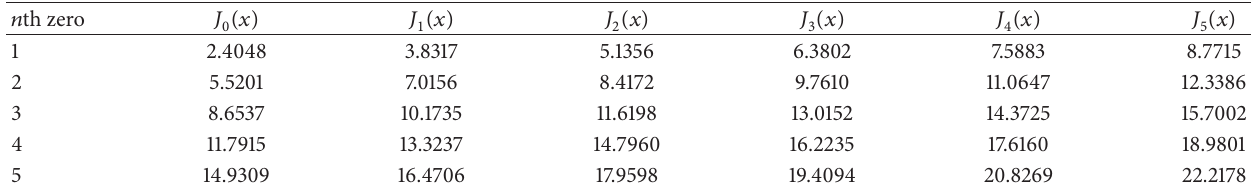
Table 1: Zeros of the Bessel functions 𝐽 𝑚 (𝑥)